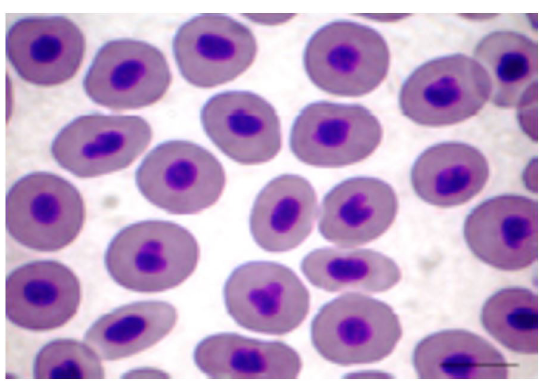
Figure 2. Blood cells of tuvira, Gymnotus spp., and erythrocyte staining with May-Grünwald-Giemsa-Wright. Bar = 10 μ